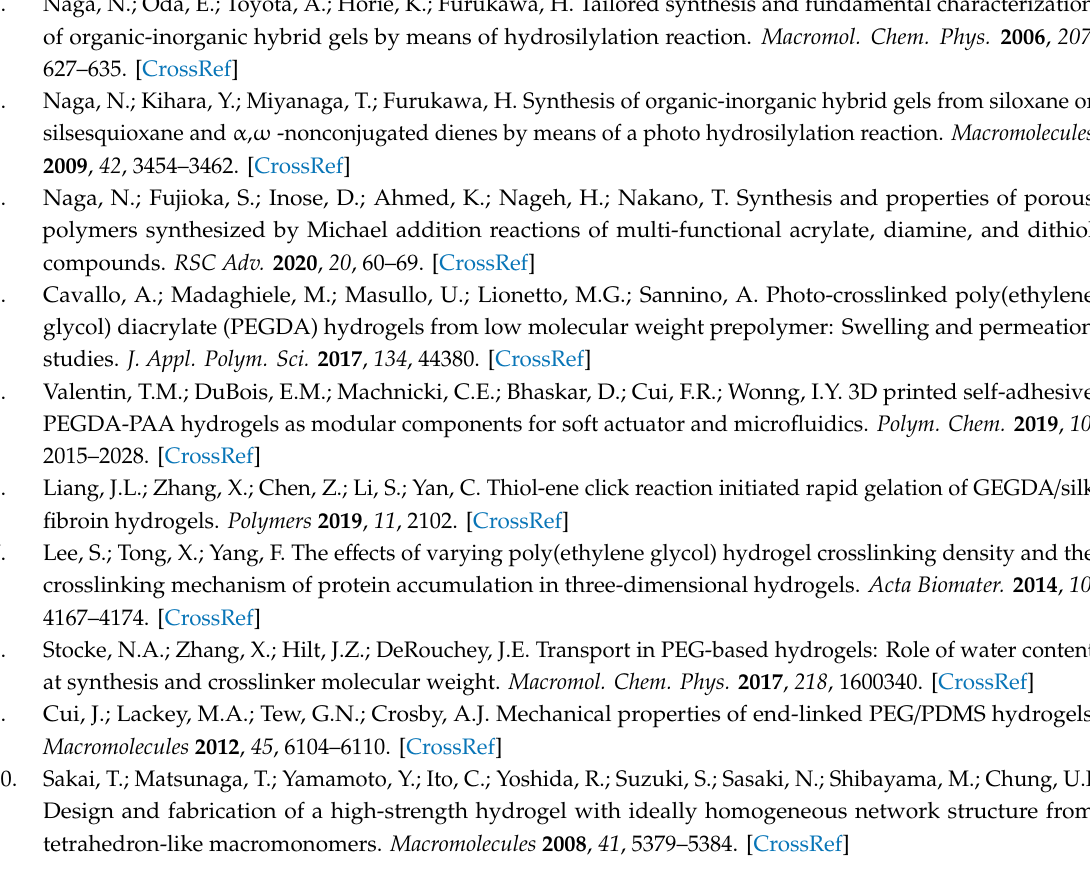
Figure S1: FT-IR spectra of PEI-PEGDE400 reaction system Case 2; Figure S2: Time evolution of viscosity of PEI-PEGDE400 and PEI-PEGDE1000 reaction systems in H2O; Figure S3: Time evolution of viscosity of PEI-PEGDE400 reaction systems in DMSO; Figure S4: FT-IR spectra of PEI-PEGDA400 reaction system of Case 2; Figure S5: Time evolution of viscosity of PEI-PEGDA200, PEI-PEGDA400, and PEI-PEGDA600 reaction systems in DMSO; Figure S6: Time evolution of viscosity of PEI-PEGDA400 and DETA-PEGDA400 reaction systems in DMSO; Figure S7: Time-evolution of PEI-PEGDA400, PEI-PEGDA600, and PEI-PEGDA1000 reaction systems in EtOH; Figure S8: Time-evolution of viscosity of DETA-PEGDA400, DETA-PEGDA600, and DETA-PEGDA1000 systems in EtOH; Figure S9: Adsorption isotherm of PEI-PEGDA200 and DETA-PEGDA200 porous polymers; Figure S10: Cycle test (compression and release) of DETA-PEGDA200 porous polymer; Table S1: A ffi nity of PEG and solvents calculated by Hansen solubility